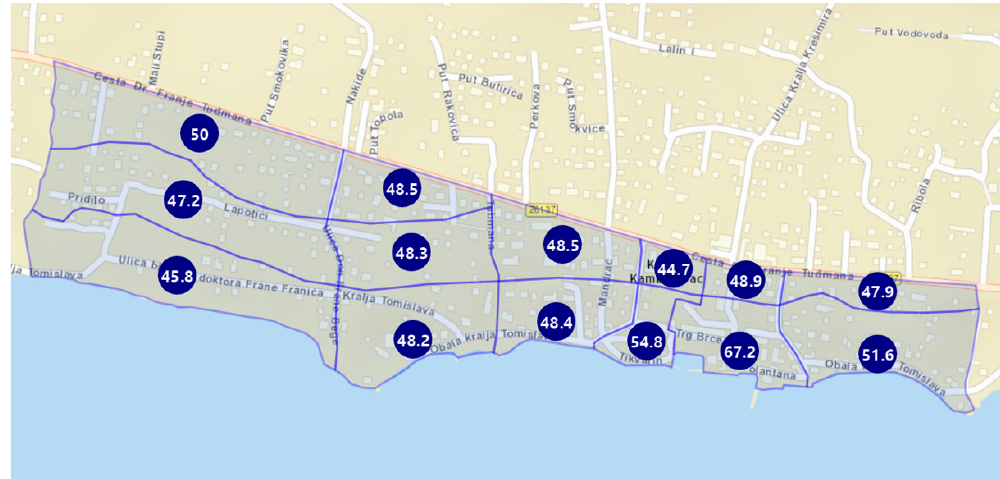
Figure 22. Results of the combined risk analysis for seismic, flood and extreme waves hazards for Level 3 (Scenario S-F-EW L3).